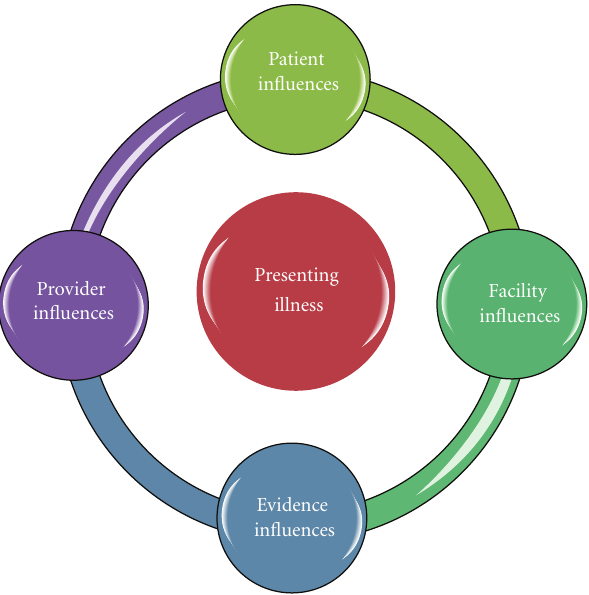
Figure 3: Factors associated with process variation in the assess- ment and management of patients presenting to the emergency